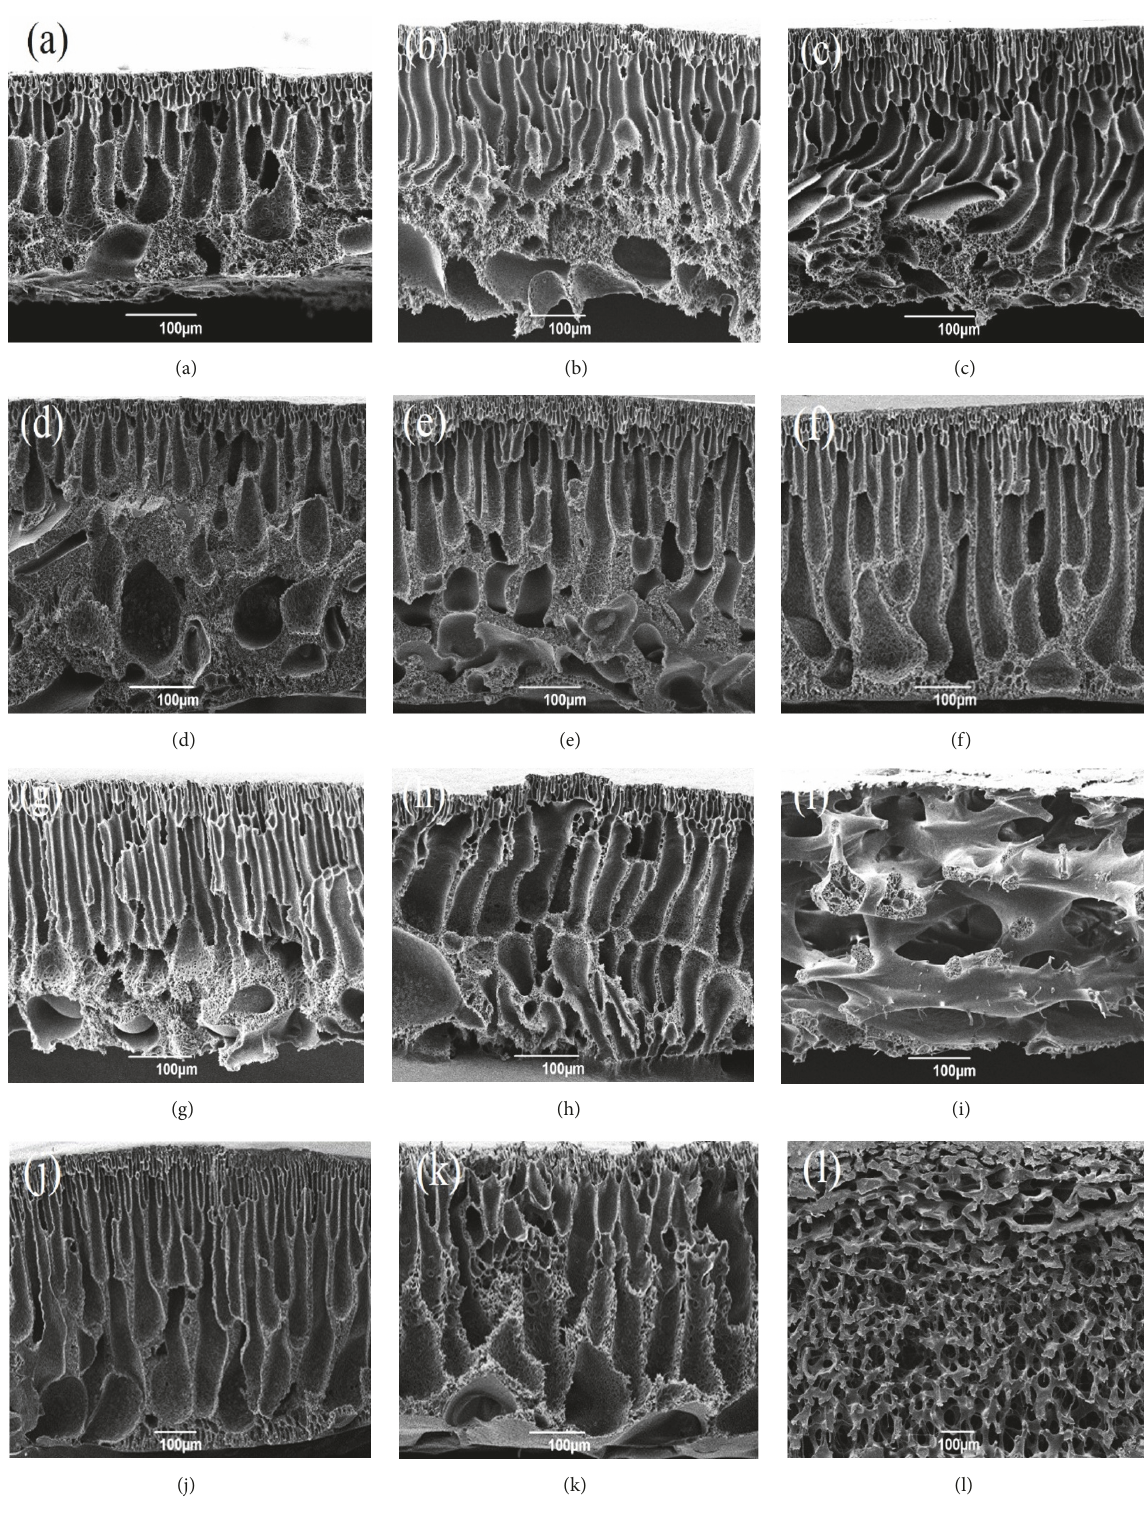
Figure 10: SEM cross-section of membranes produced from Cyrene and different concentrations of PVP: 0% (a, d), 0.1% (b, e), 0.5% (c, f), 1% (g, j), 5% (h, k), and 10% (i, l) in cold (first letter) and hot gels (second